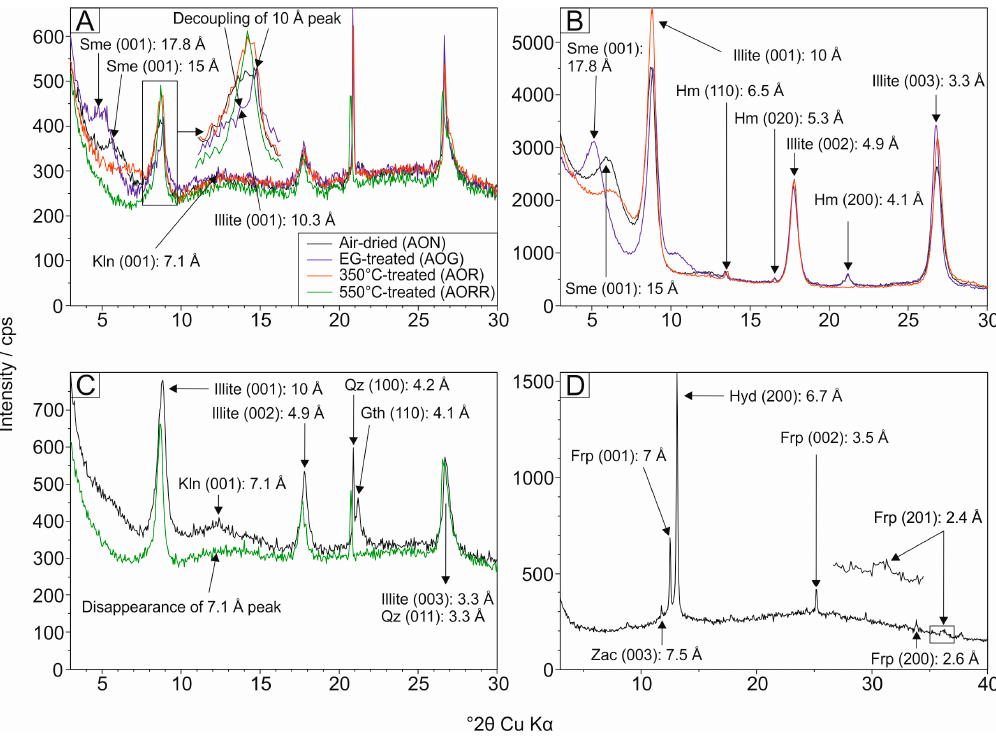
Figure 4. XRPD patterns of AON, AOG, AOR, and AORR oriented aggregates from residues of 5 min/5000 rpm and 40 min/8000 rpm centrifugation cycles. ( A ) The XRPD patterns of the Ethylene-glycol (EG)-treated aggregate (AOG) show the decoupling of the 10 Å peak (AON) into 10.3 (left) and 9.97 (right) Å reflections (sample CR07-14_5/5000); ( B ) Example of I/S mixed layers in the Cristal samples. Hemimorphite (Hm) residues are still detectable in the sample (CR13-7_40/8000); ( C ) The XRPD patterns of the AOR oriented aggregate show the disappearance of the 7.1 Å reflection of kaolinite (Kln) (sample CR02_5/5000); ( D ) The XRPD pattern of the AON oriented aggregate shows the diagnostic reflections of fraipontite (Frp) and the 003 spacing of zaccagnaite (Zac) in a hydrozincite-rich sample from the Mina Grande deposit (sample ZB-1_5/5000).